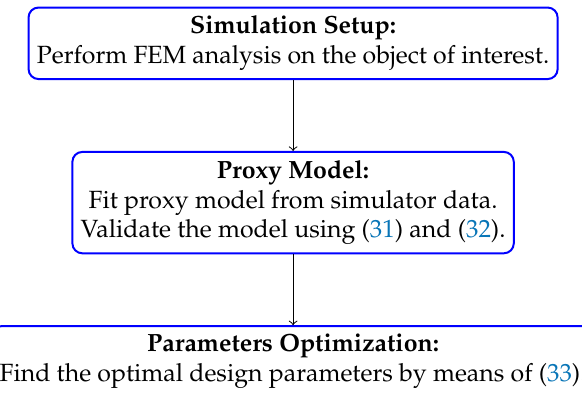
Figure 4. Steps for the synthesis of a